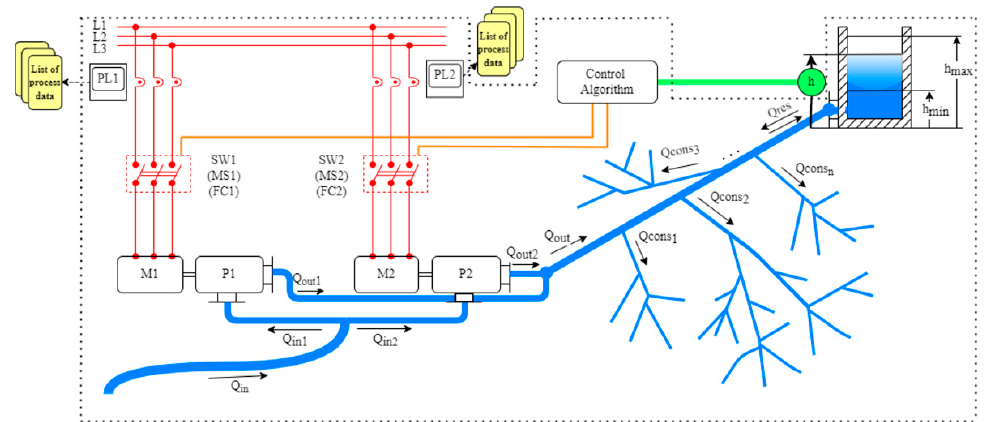
Figure 2. The physical model of a PS with two PUs pumping water into the discharge–distribution piping system with one counter-tank.